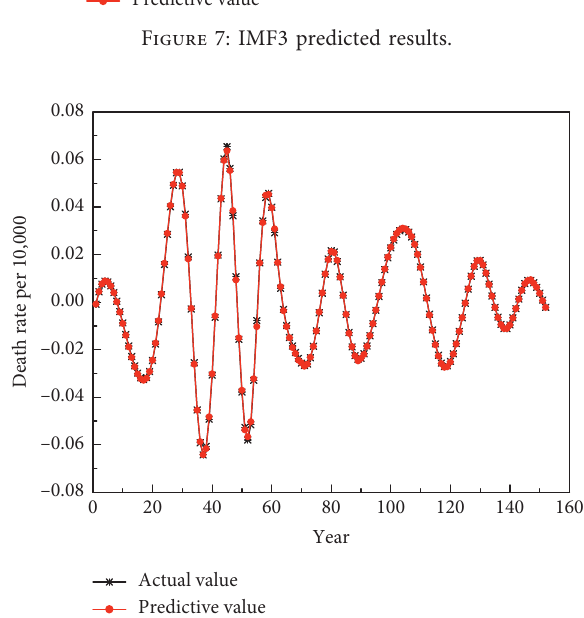
Figure 5: IMF1 predicted results.